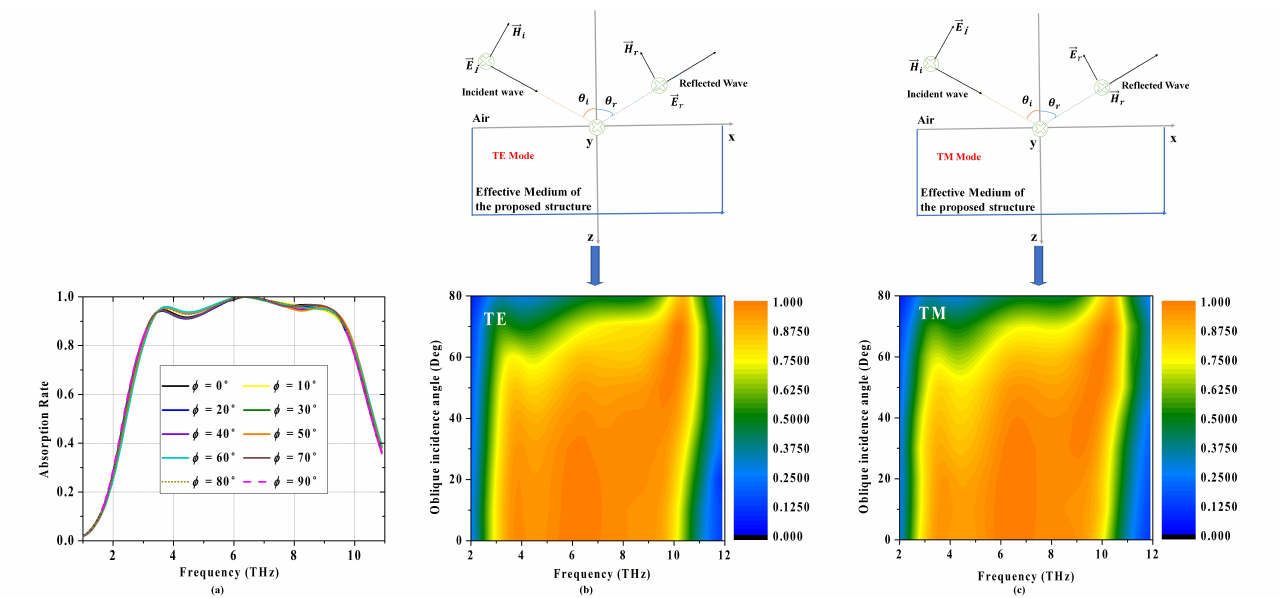
Figure 8. ( a ) Absorption rate under various polarization angle. ( b ) Absorption contour map of the absorber under various incident angles of ( b ) TE mode and ( c ) TM mode.